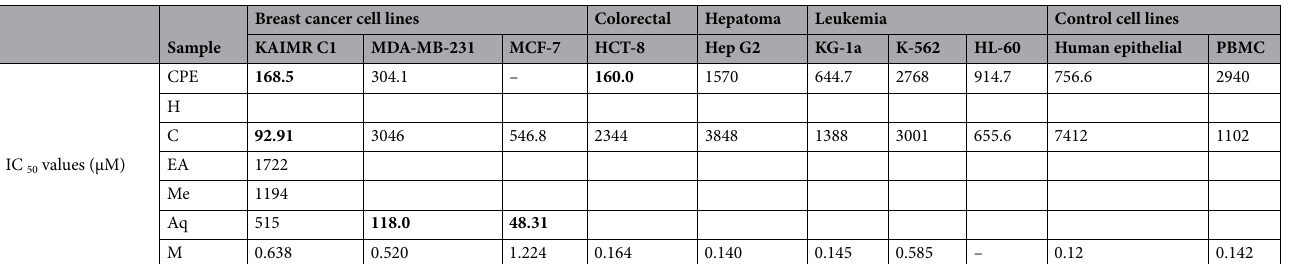
Table 4. IC 50 values (µM) exhibited by the crude polyphenolic extract (CPE) and its fractions ( H : hexane, C: chloroform, EA: ethyl acetate, Me: methanol; Aq: aqueous) of C. racemose and the standard drug (M: mitoxantrone) on different cancer (breast, colorectal, hepatoma and leukemia and normal (epithelial and monocular blood) cell lines. Significant values are in bold.